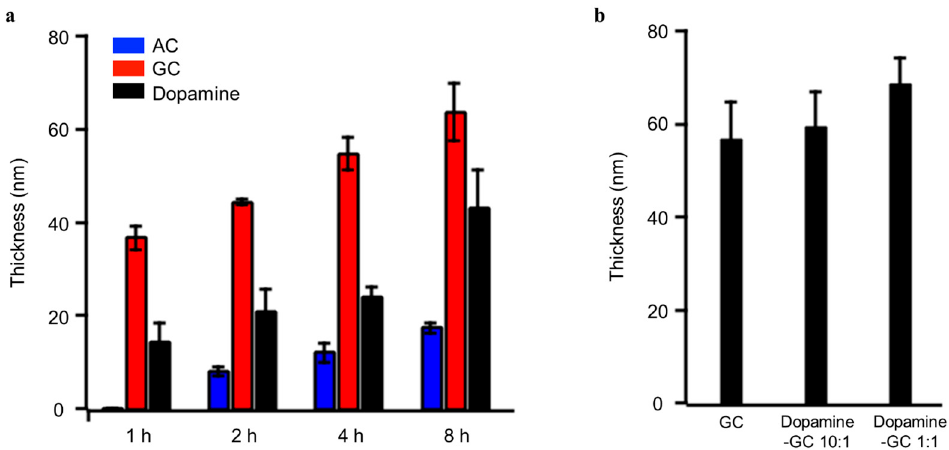
Figure 3. ( a ) Thicknesses of films formed from AC and GC (5 mg/mL) and dopamine